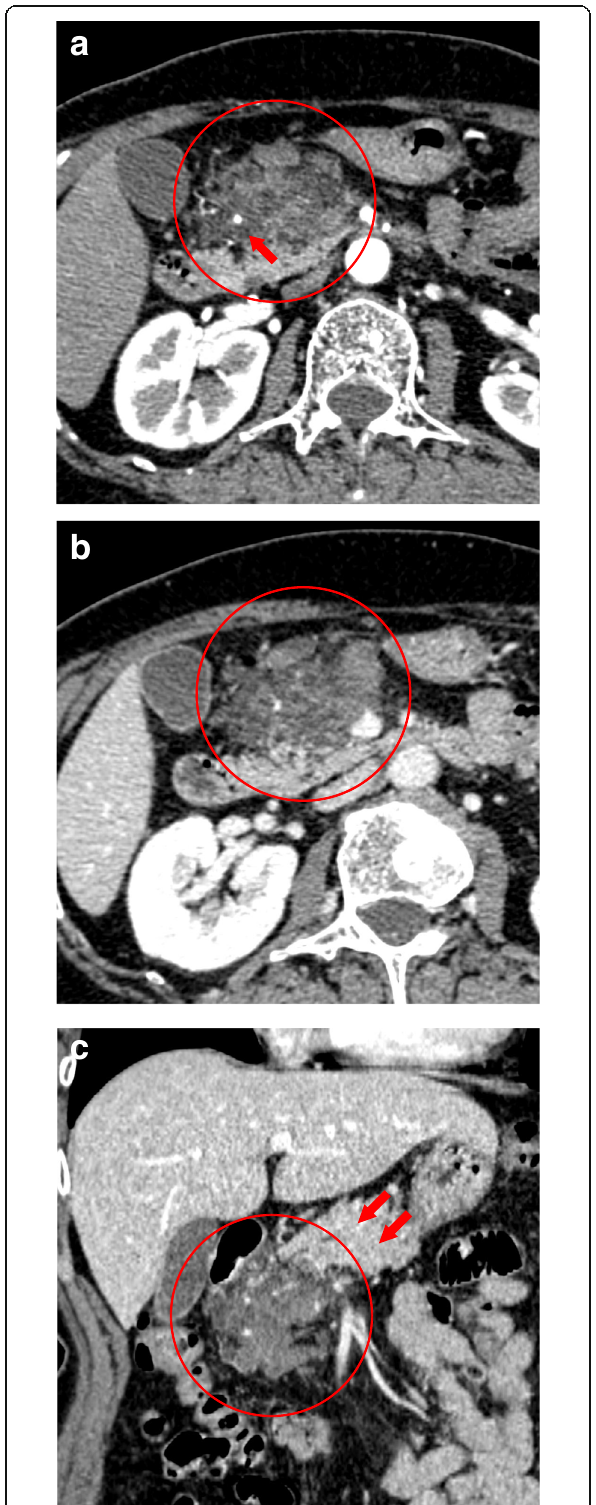
Fig. 1 The contrast-enhanced dynamic CT scan showed a 60- mm-diameter tumor in the pancreatic uncinate process (red circle in each image). a Arterial phase (red arrow: gastroduodenal artery). b , c Portal vein phase (red